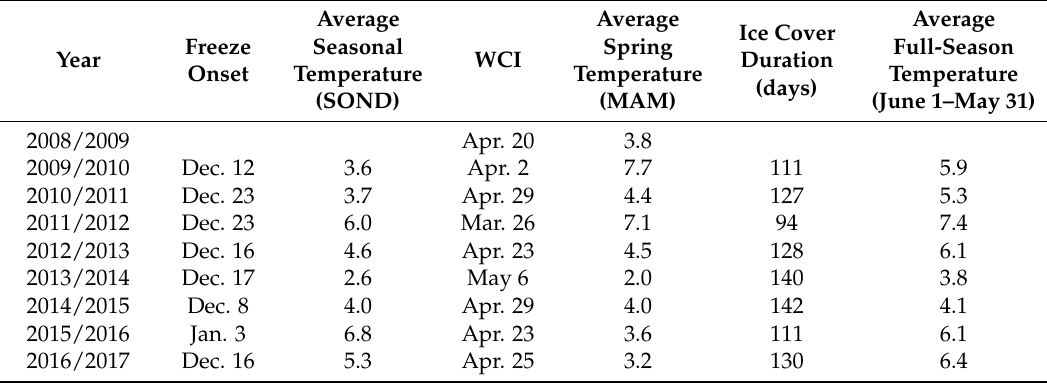
Table 5. Average date of freeze onset and average seasonal/annual temperatures ( ◦